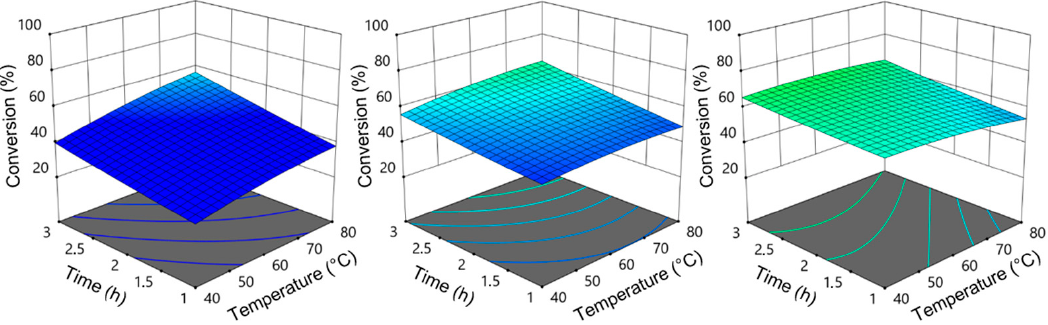
Figure 3. The 3D plots obtained when the molar ratio of the reactants was the lowest (4:1) and the value of the mass fraction of the catalyst was the lowest (1%, ( left )), medium (2%, in the ( middle )) and the highest (3%, ( right )).